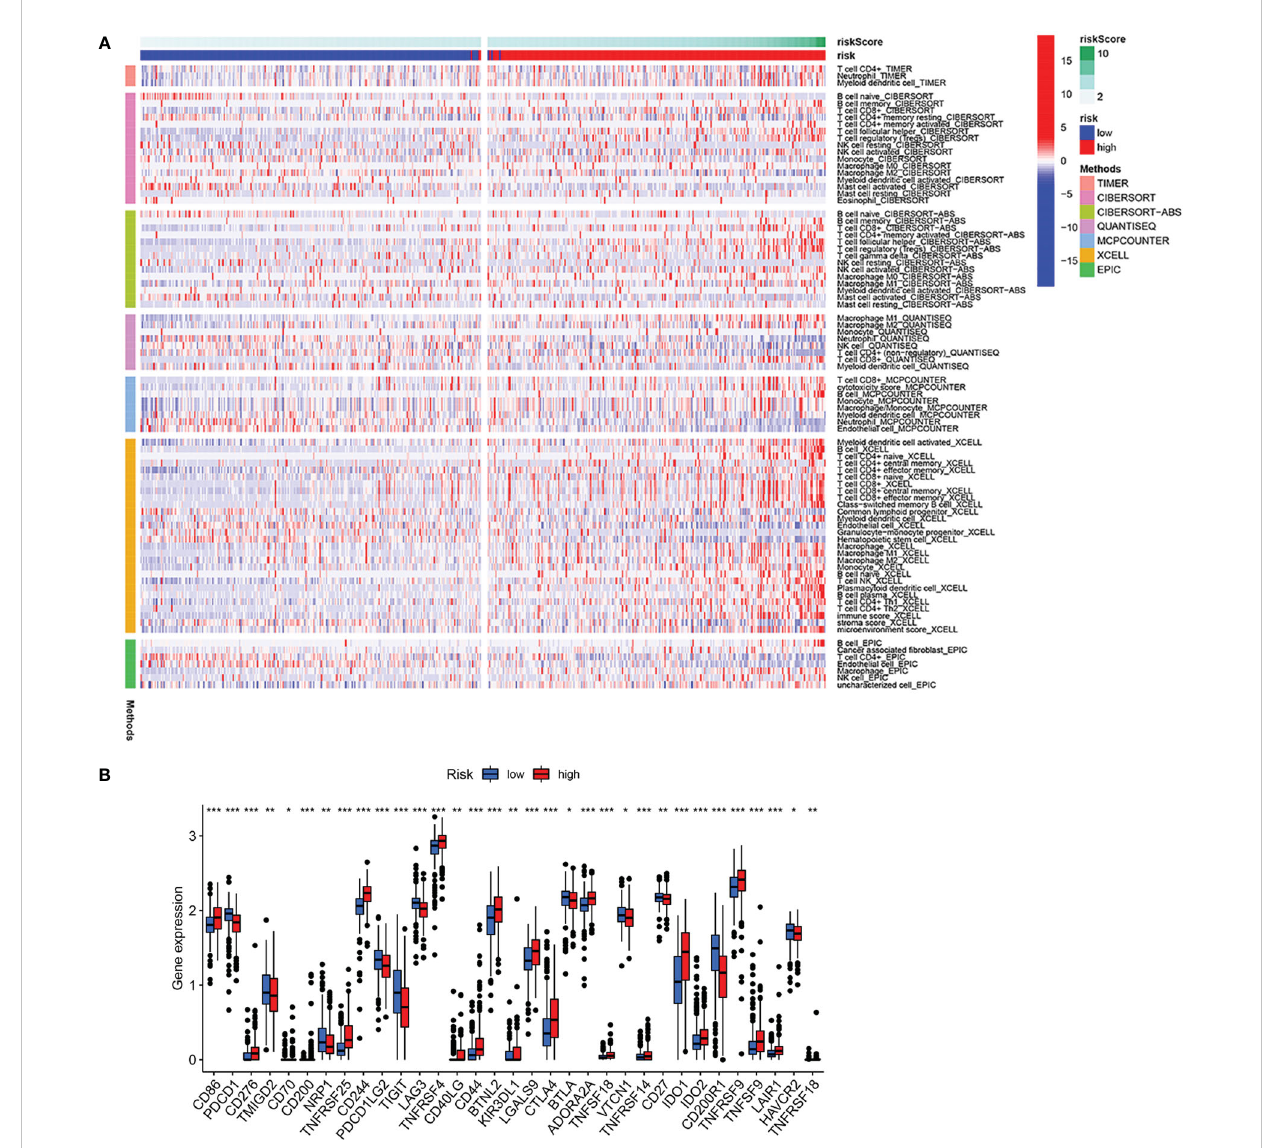
FIGURE 8 Analysis of immune in fi ltration and immune checkpoint. (A) Heatmap of immune cell in fi ltration in high-risk group and low-risk group. (B) Differential expression of immune checkpoint genes in high-risk group and low-risk group. *p<0.05, **p<0.01,